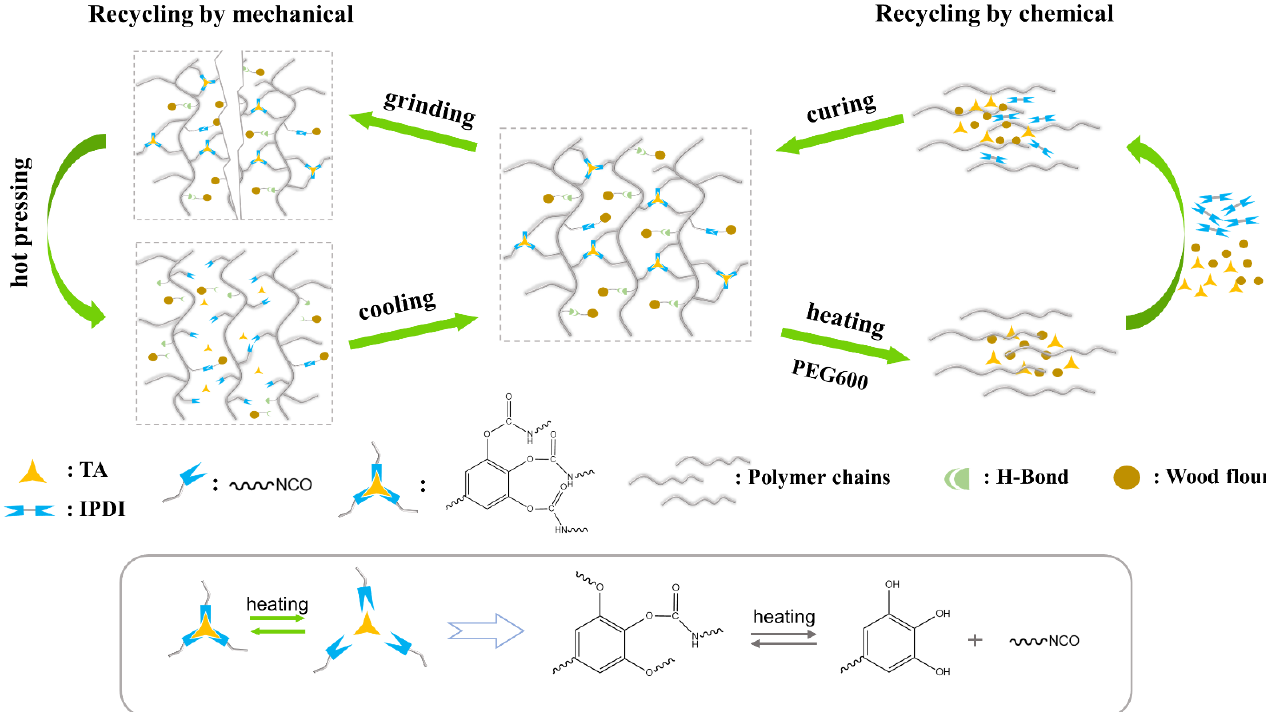
Figure 8. Schematic of the recycling mechanism of UWPU composites.